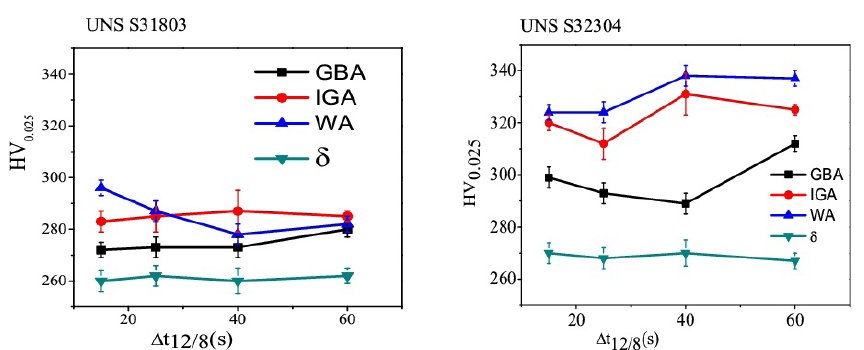
Figure 5. The hardness values of the different austenite morphological forms and ferrite corresponding to the HAZ microstructures at the tested cooling times of the UNS S31803 and UNS S32304